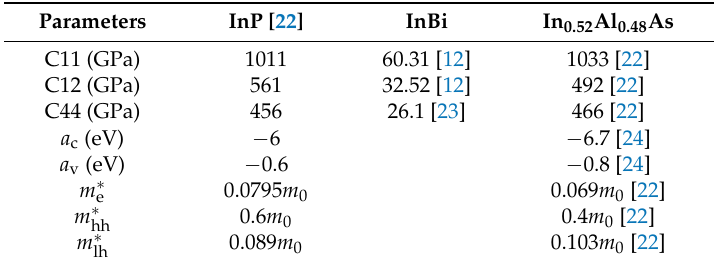
Table 1. Summary of the parameters used for the